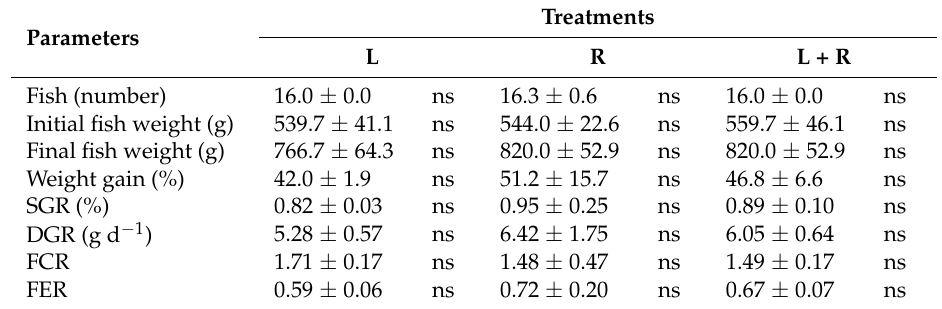
Table 7. Pangasius production parameters (average ± standard deviation). ns = not significant